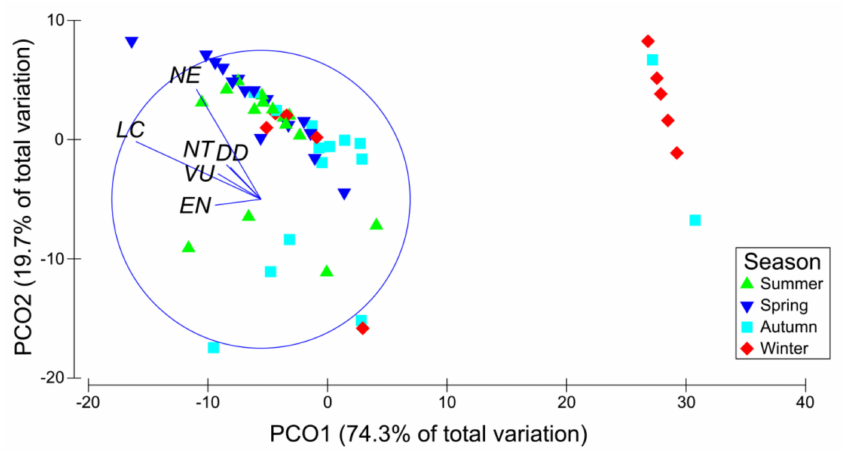
Figure 6. Principal coordinate analysis plot (PCoA) of bycatch and discards species assemblage by season according to IUCN conservation status. The first two axes explained 94% of the total variation. Conservation status categories with a Spearman rank order correlation higher than 0.6 are shown as overlying vectors.